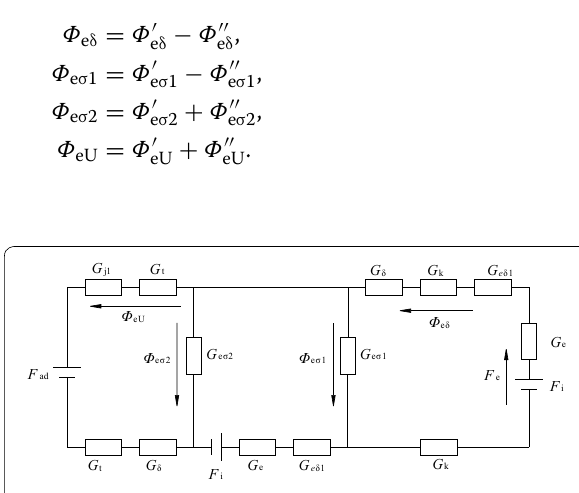
Figure 12 Salient-pole electrical excitation equivalent magnetic circuit